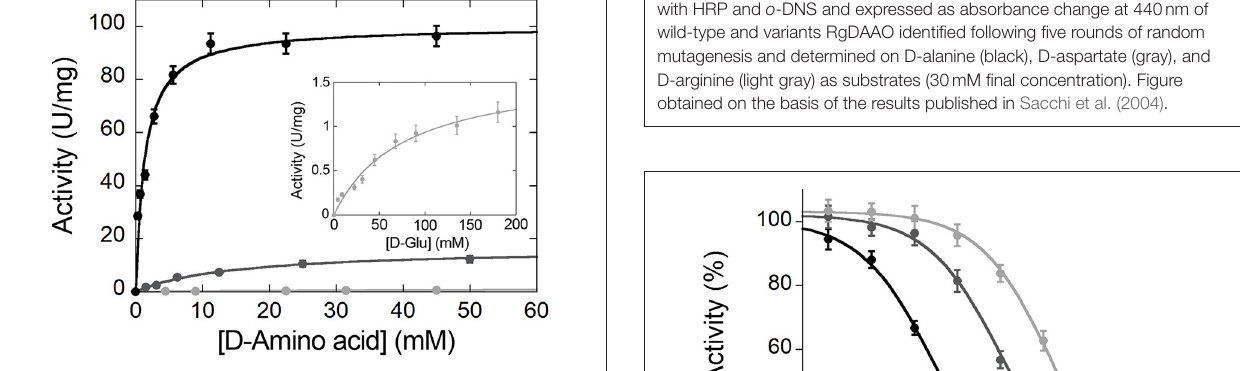
FIGURE 7 | Michaelis-Menten plot of the kinetics of wild-type RgDAAO on D-alanine (black), D-lysine (gray), and D-glutamate (light gray and inset) as substrate, at pH 8.5 and 25 ◦ C. All measurements were performed at air saturation ([O 2 ] = 0.253mM) using the oxygen consumption assay.